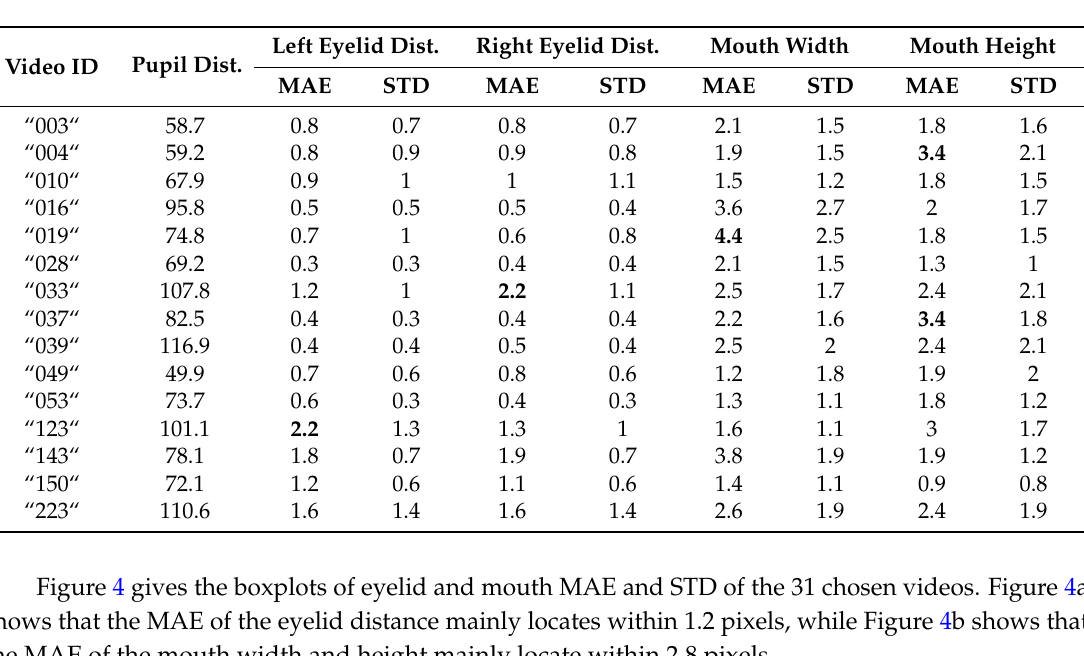
Figure 5. Eyelid distance errors for images from video ”123”. The yellow point is the ground truth, the greed point is the tracked result. The error is defined as absolute difference between the tracked eyelid distance and the ground truth. Take frame 327 for example, the left eyelid error is 2.6 pixels while the right eyelid error is 1.6 pixels. The pupil distance is 101.1 pixels for video ”123”. error = [0.5, 0.5]